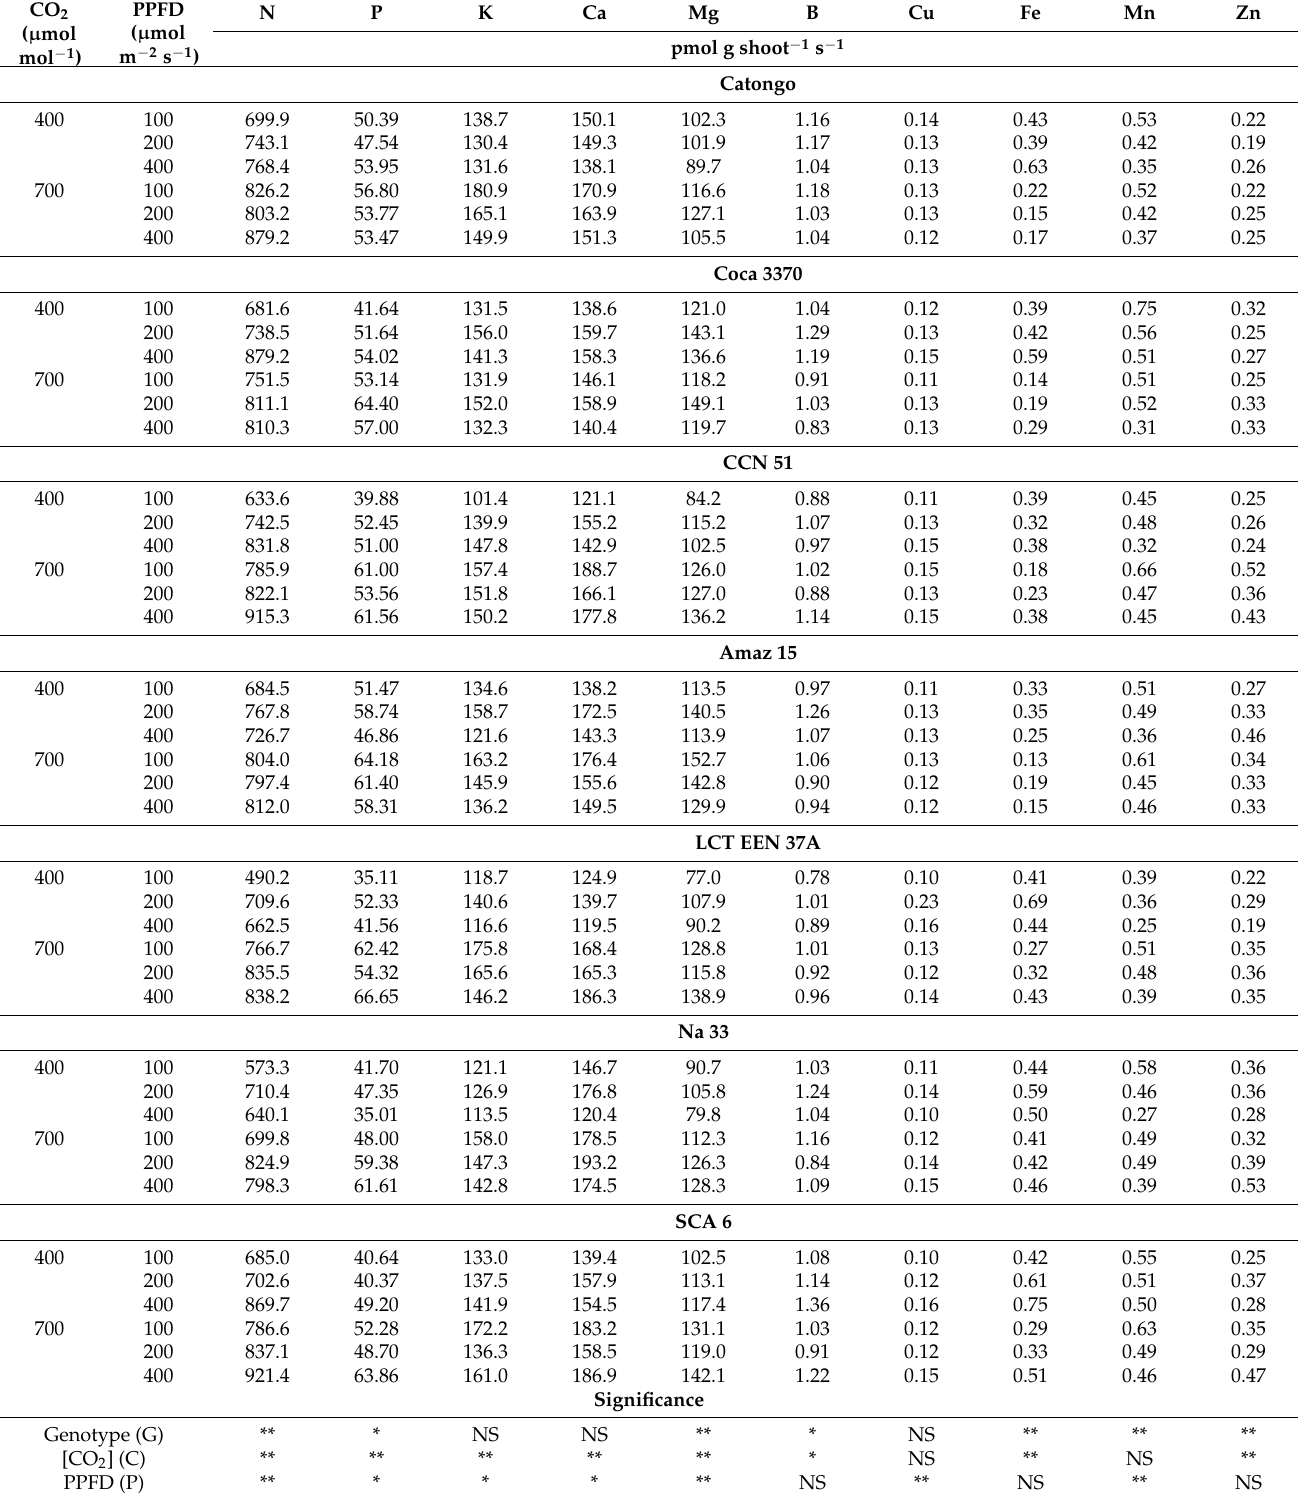
Table 6. The effect of [CO 2 ] and photosynthetic photon flux density (PPFD) on macro–micro nutrient transport of seven cacao